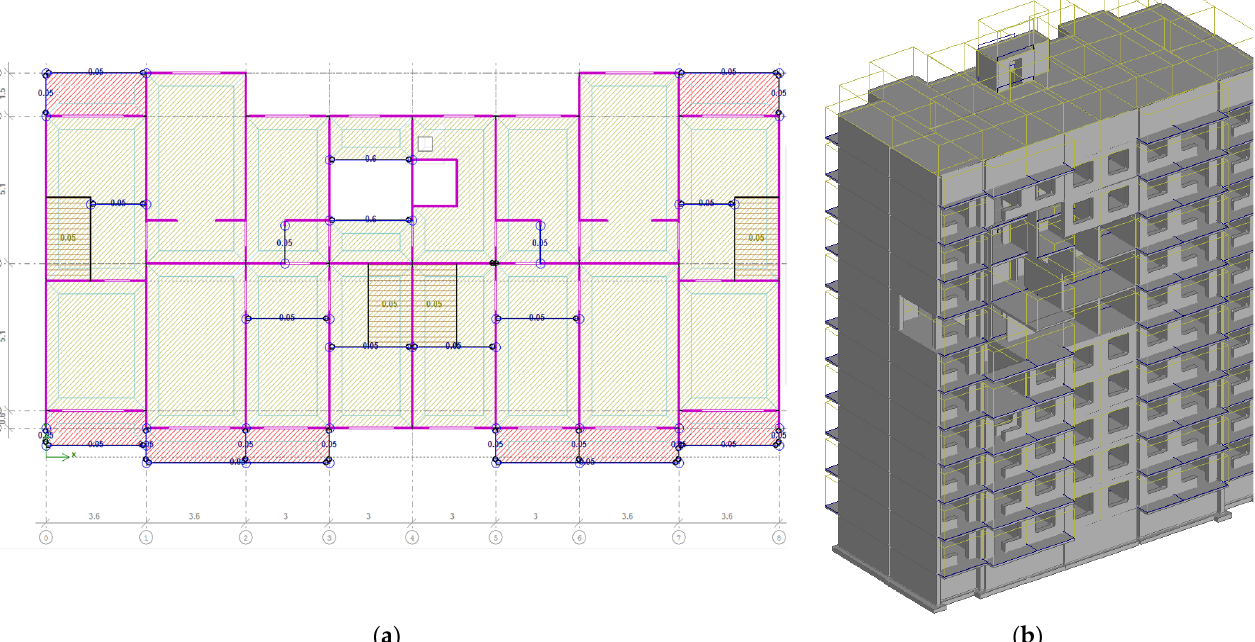
Figure 8. Creation of the spatial calculation scheme of the building: ( a ) plan of the first floor with given vertical loads of the floor slab; ( b ) 3D view of the structural scheme of the building with removed damaged elements (Kyiv city, S. Krushelnytska Street, June–October 2020).